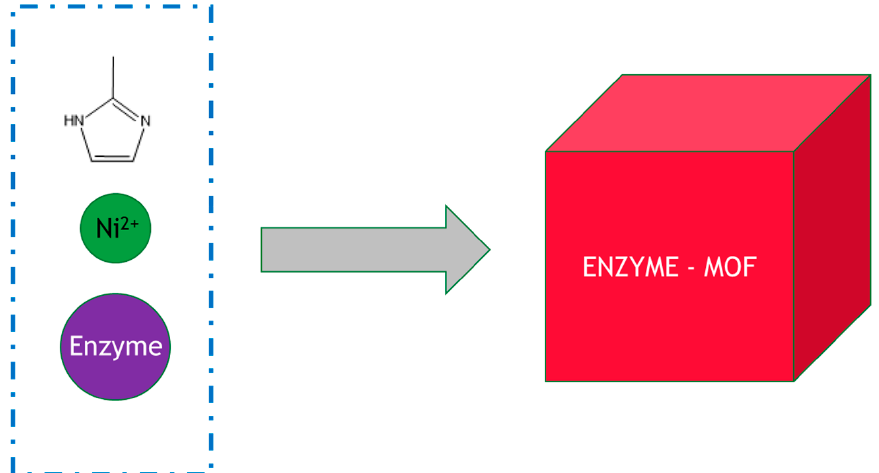
Figure 3. Synthesis of an enzyme–MOF composites in bulk solution. The reactants were added to the beaker and mixed with stirring.